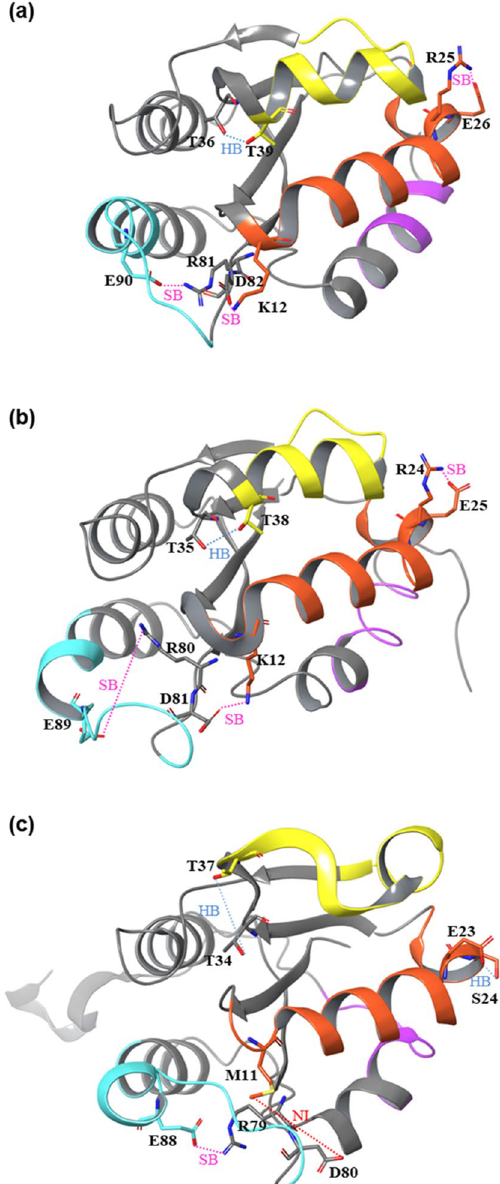
Figure 8. Modeled structures of the MGSs. ( a ) opMGS; ( b ) tsMGS; and ( c ) cdMGS. The regions of high RMSF difference are colored as orange (I), yellow (II), cyan (III) and purple (IV). The conformation of residues between which the distances are measured are indicated with the expected interactions such as salt bridge (SB), hydrogen bond (HB) and no corresponding interaction